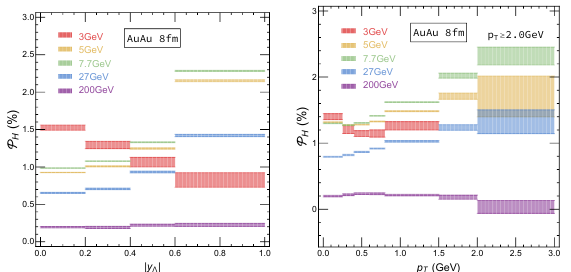
Figure 2. Λ global polarization signal for AuAu collisions at impact parameter b = 8 fm for a variety of collision beam energy from 200GeV down to 3GeV, with the bands representing statistical uncertainty from our simulation. Left: as a function of rapidity y ; Right: as a function of transverse momentum p T .